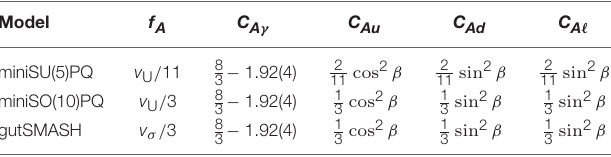
TABLE 4 | Axion predictions in SU (5) SO (10) U (1) PQ models (Ernst et al., 2018): axion decay constant f A , coupling to × the photon C A γ , and tree-level couplings to quarks and charged leptons C Ai , i u ,..., t , e ,.., τ . =